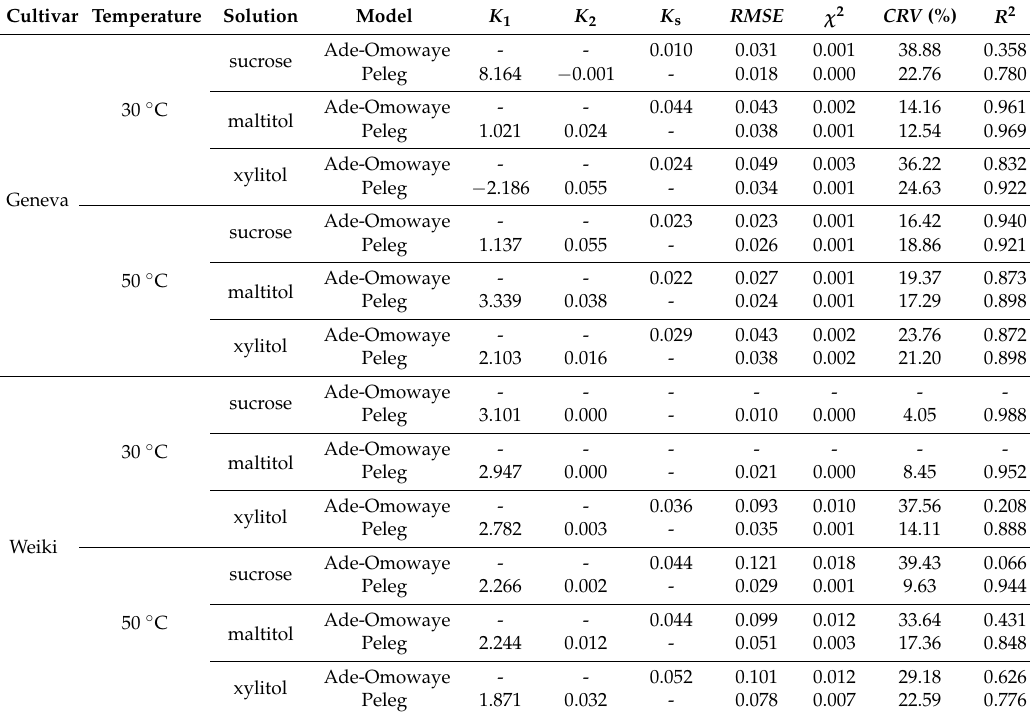
Table 7. Values of RMSE , χ 2 , R 2 and CRV of best fitting mathematical model of SG. Cultivar Temperature